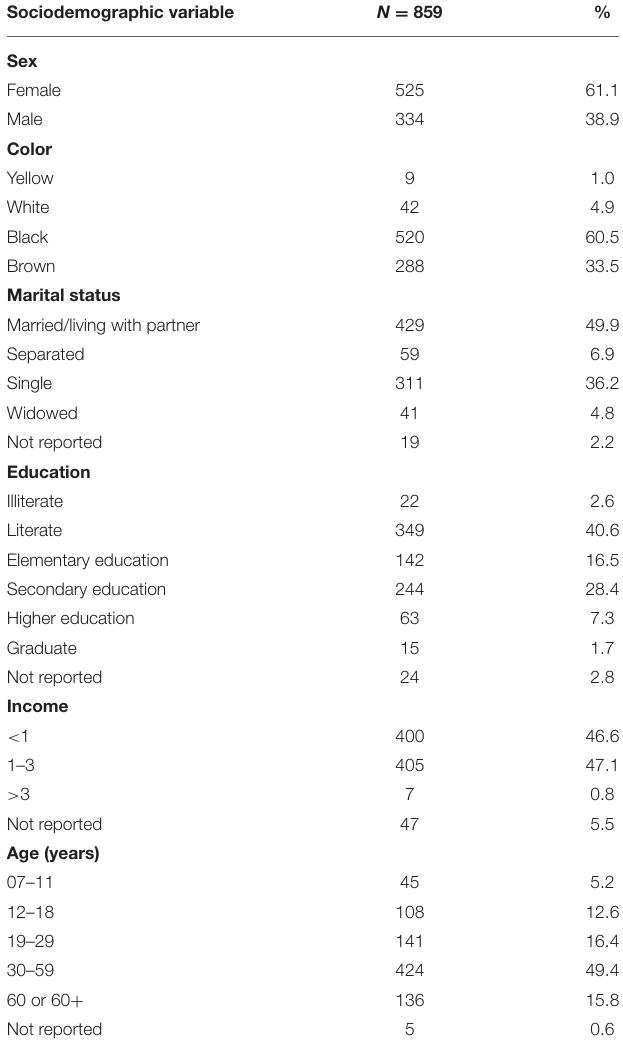
TABLE 1 | Sociodemographic profile of the study